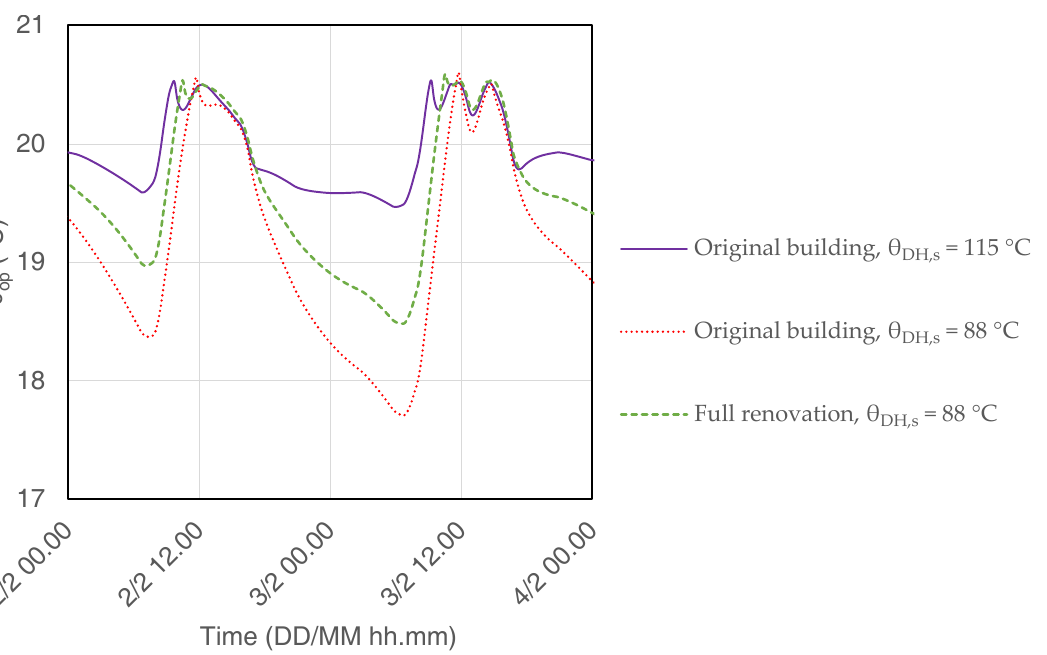
Figure 12. Indoor operative temperature in a winter period for a single family house built between 1961 and 1975. Operative temperature set-point: 20.5 ◦